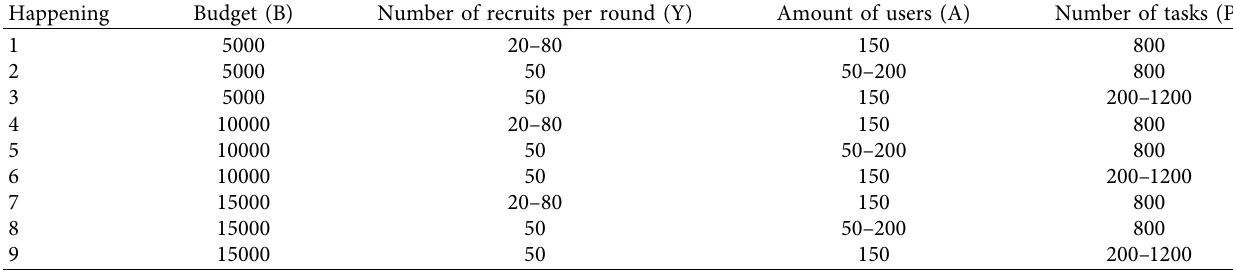
Table 2: Experimental setting of Algorithm 2.